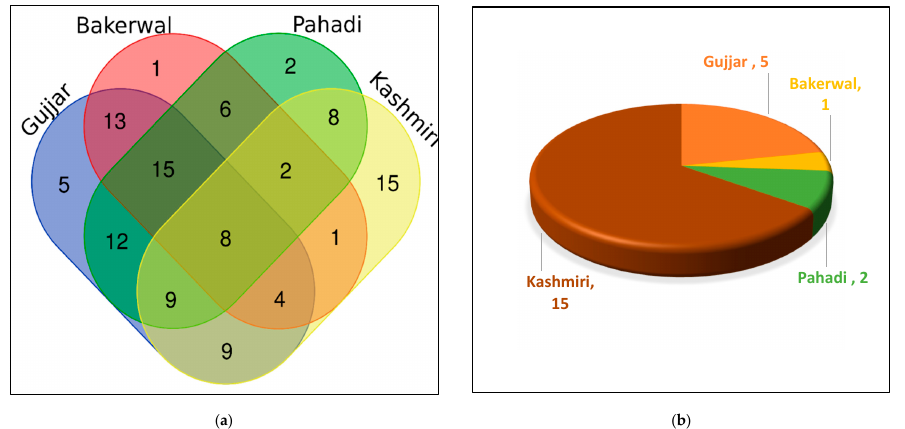
Figure 6. ( a ) Venn diagram showing the overlap of ethnomedicinal usage of plants. ( b ) Plant species uniquely used by different ethnic groups.